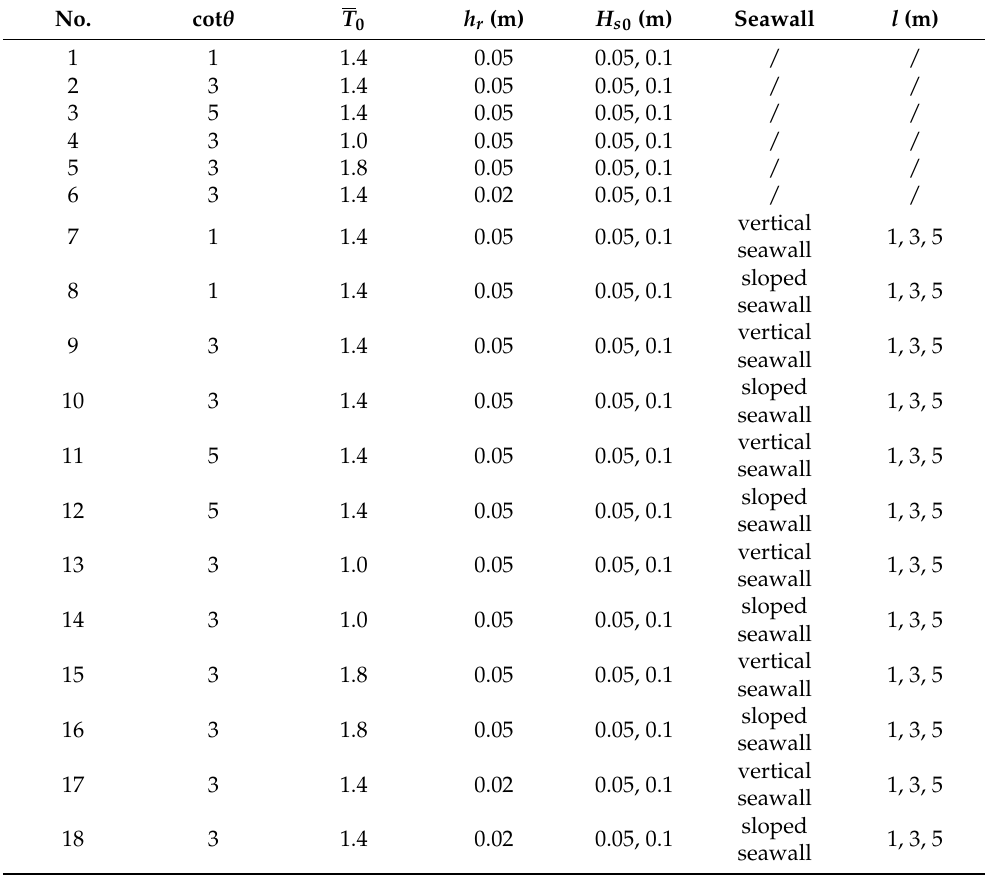
Table 2. Experimental test cases for the irregular wave acting on the